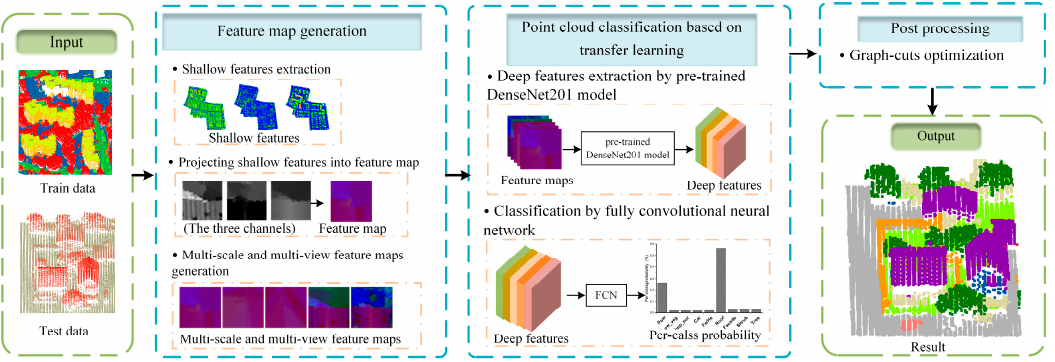
Figure 1. The flow chart of the proposed classification method.